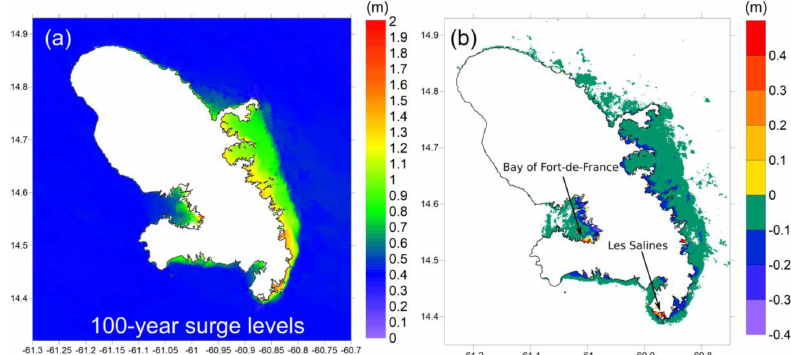
Figure 7. 100-year surge levels for present climate and no SLR (a) , as well as difference between 100-year surge levels for present climate when considering a 1m sea level rise (b)